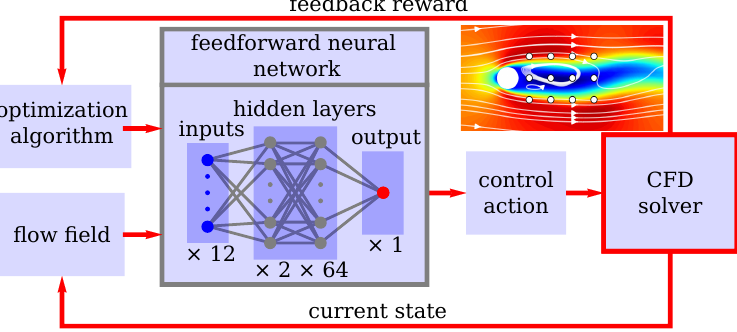
Figure 2. Active closed-loop flow control optimization scheme.